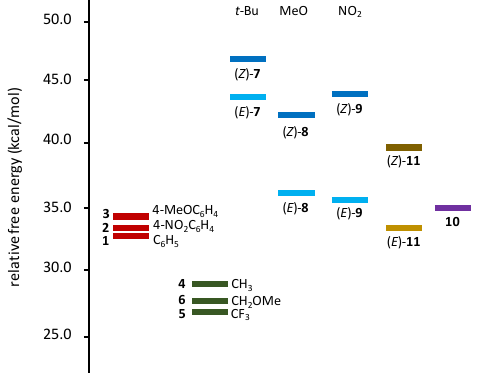
Figure 1 . Energy barriers for the 2-aza-Cope rearrangement of nitrones 1 – 11 . For nitrones 1 – 6 , aromatic (red series) and aliphatic (green series) substituents correspond to one side of the nitrone fragment. For nitrones 7 – 9 (R 1 =R 2 = Ph), ( E )-isomers (cyan) have lower barriers than ( Z )-isomers (blue); substituents correspond to allylic fragment.